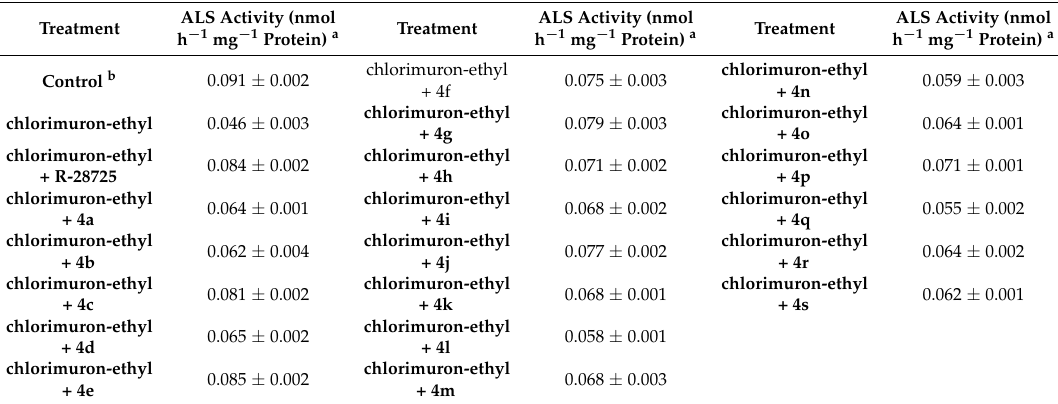
Table 3. Effect of Compounds 4a – s and chlorimuron-ethyl on the acetolactate synthase (ALS) activity of maize.